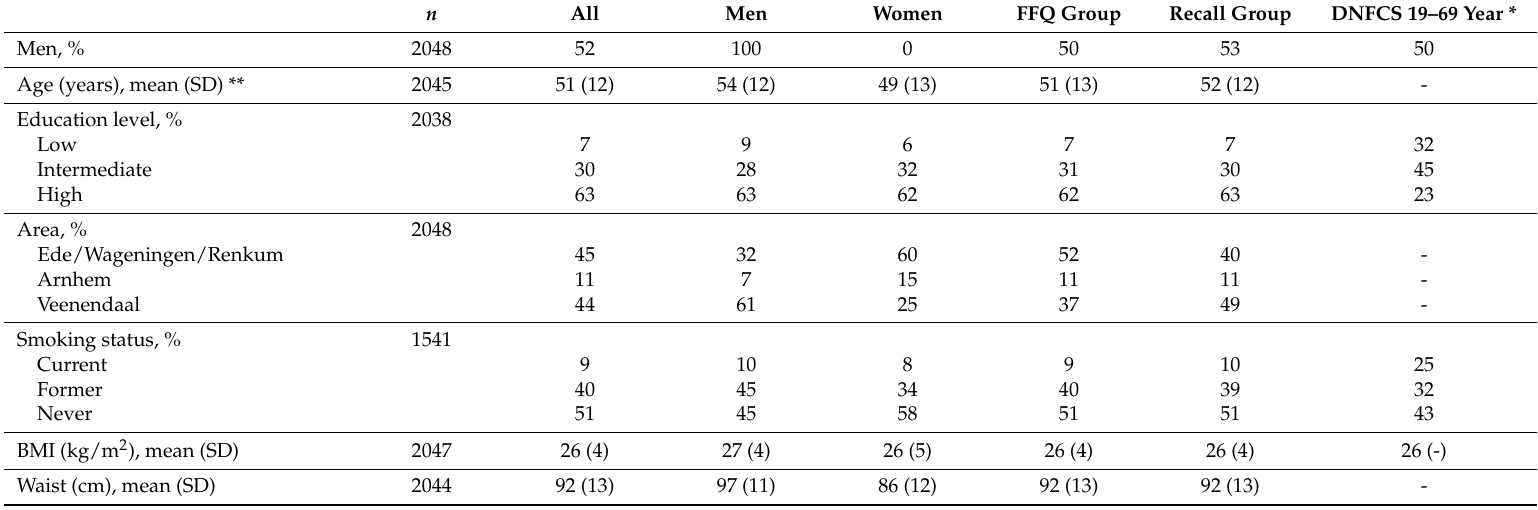
Table 3. Comparison of the participant characteristics of the NDARD project ( n = 2048) and the Dutch National Food Consumption Survey (DNFCS) ( n =